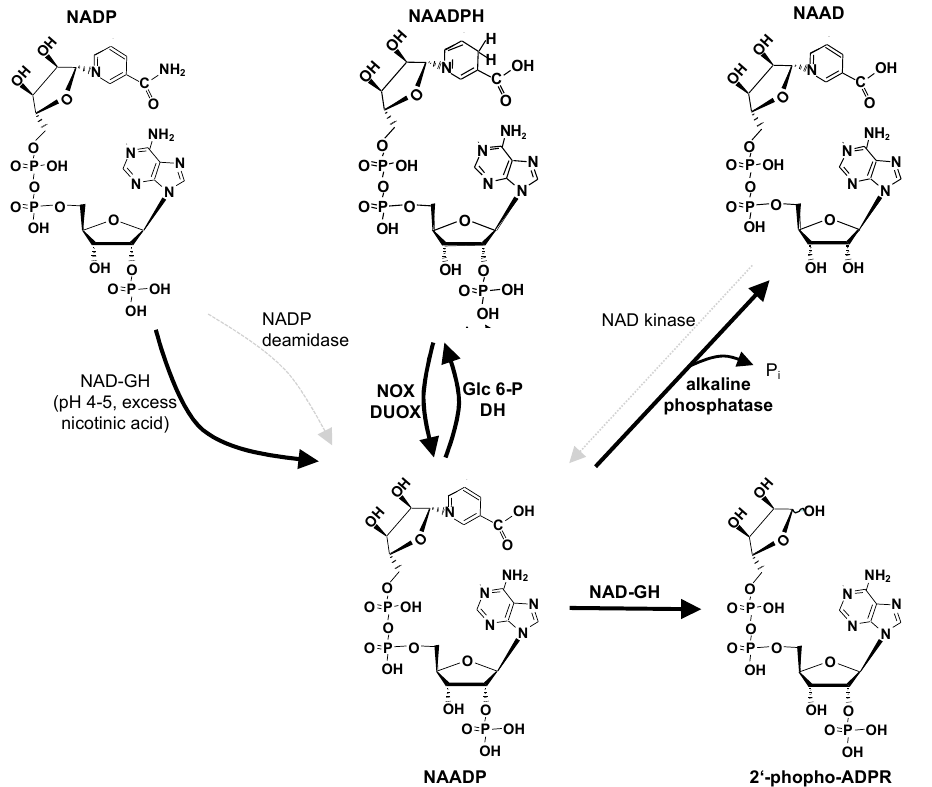
Figure 2. Enzymology of NAADP metabolism: hypothetical and confirmed pathways. Hypothet- ical pathways are marked by dotted lines in gray. Solid, bold lines indicate confirmed pathways.